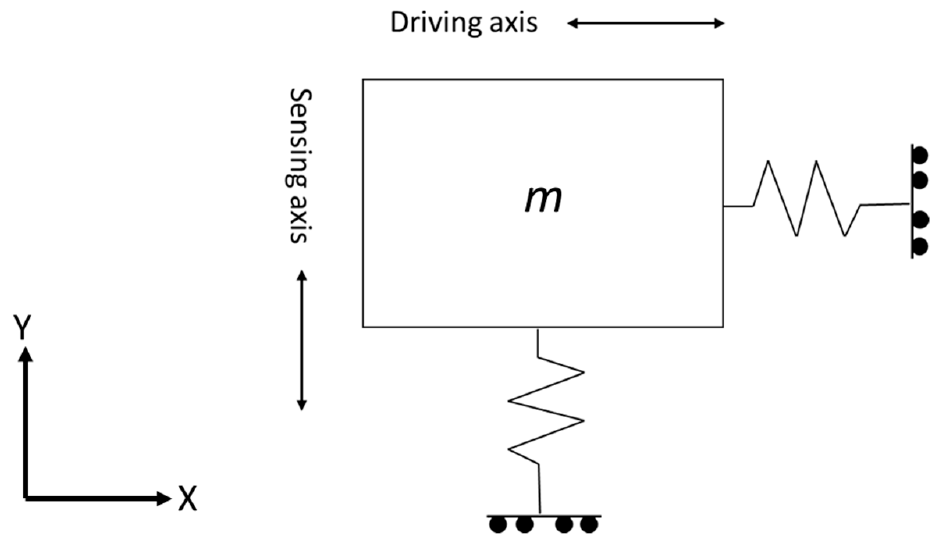
Figure 1. Simple depiction of a proof mass vibrating system.